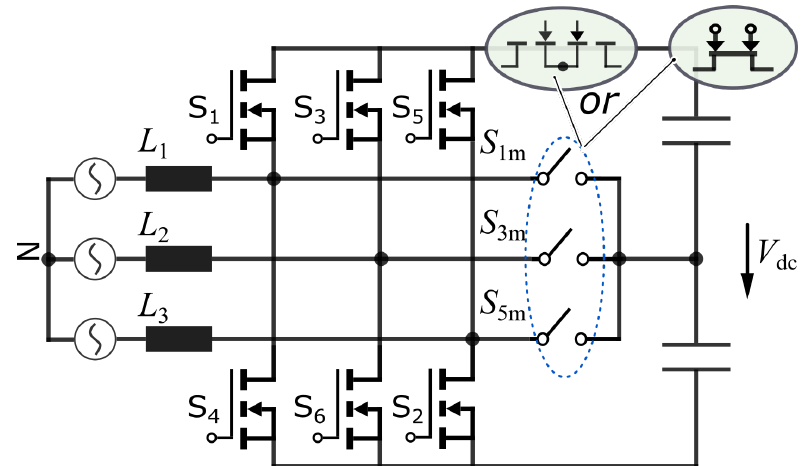
Figure 12. T-type active-front-end rectifier using Si/SiC MOSFETs and GaN transistors [63]. Table 4. Comparison of three-phase active front end converter